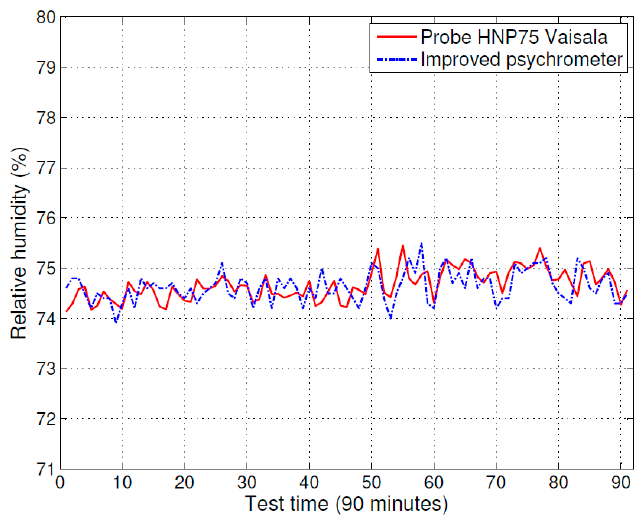
Figure 4. Comparison of measurement accuracy between the improved psychrometer and relative humidity instrument (HMP75).